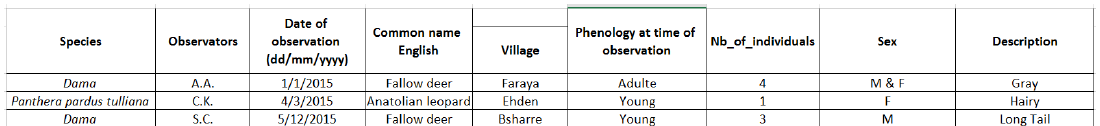
Figure 12. Running example: Multi-mapping.